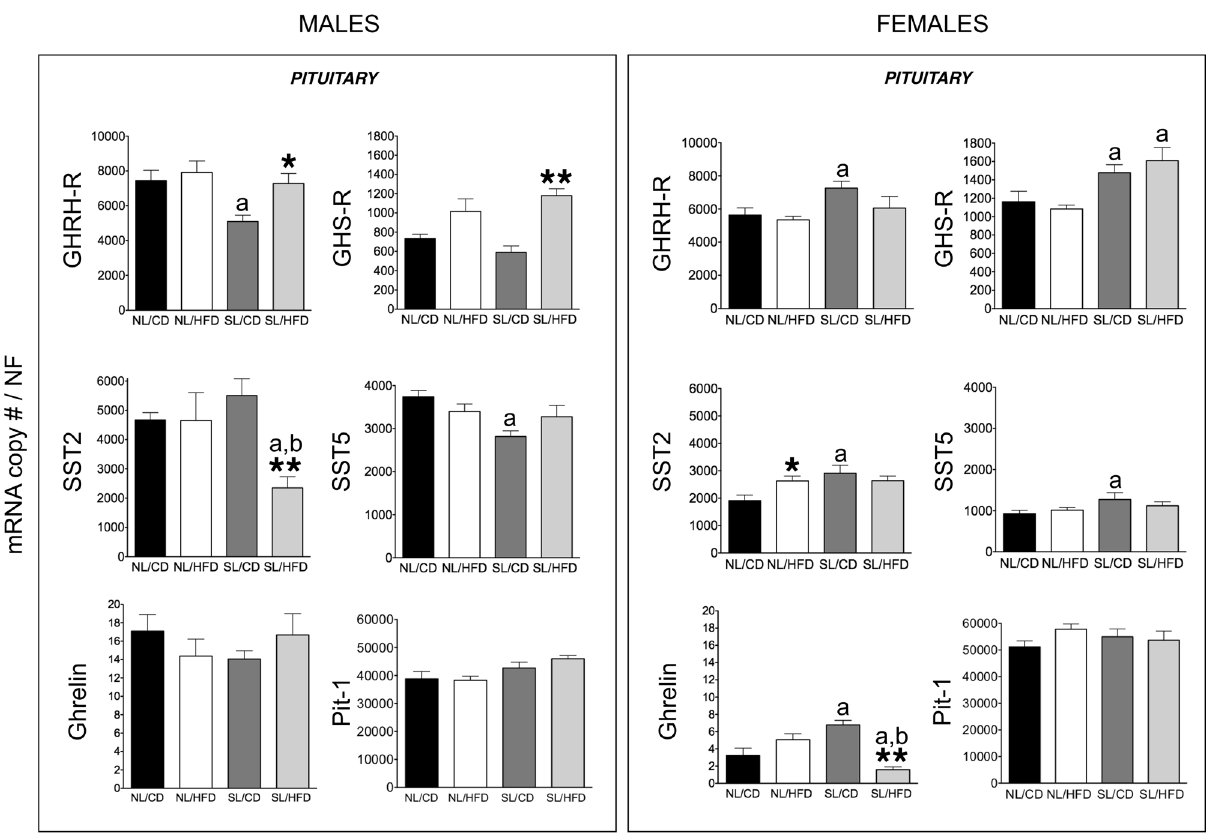
Figure 3. Pituitary GHRH-R, GHS-R, SST2, SST5, ghrelin and Pit-1 mRNA levels in male ( left panels ) and female rats ( right panels ) subjected or not to overfeeding during lactation (SL vs. NL) and/or HFD after weaning (HFD vs. CD). mRNA copy numbers were determined by qPCR and adjusted by a Normalization Factor (NF) in each sample obtained from the expression levels of three housekeeping genes ( β-actin , Hprt and C yclophilin A ). Data are presented as mean ± standard error of the mean (SEM), n = 8 per experimental group. Statistically significant differences were assessed by two-way ANOVA to analyze the effects of litter size and diet and their litter